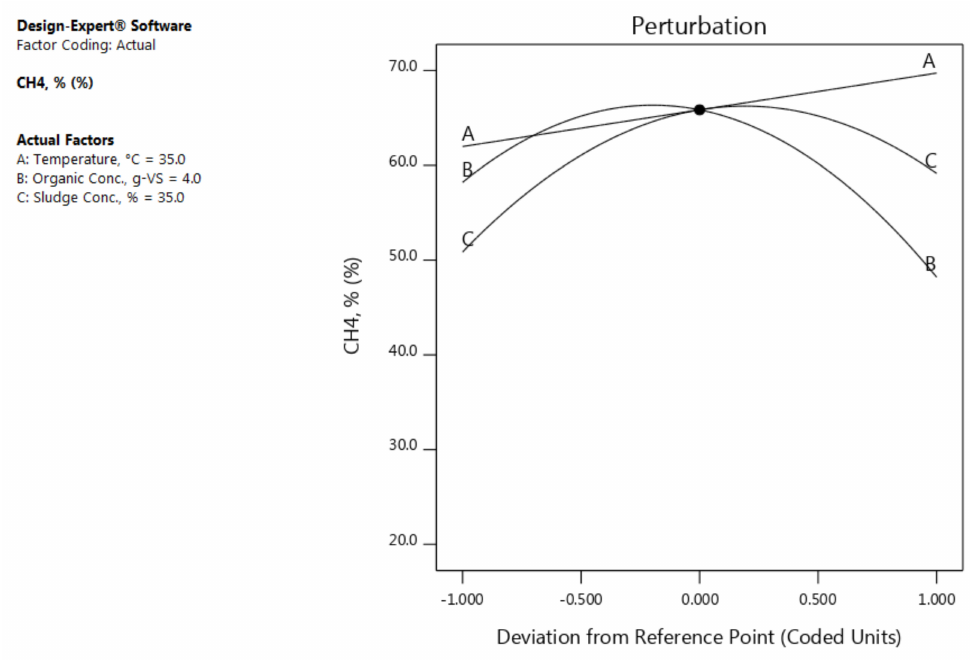
Figure 4. The perturbation plot of CH 4 % response.